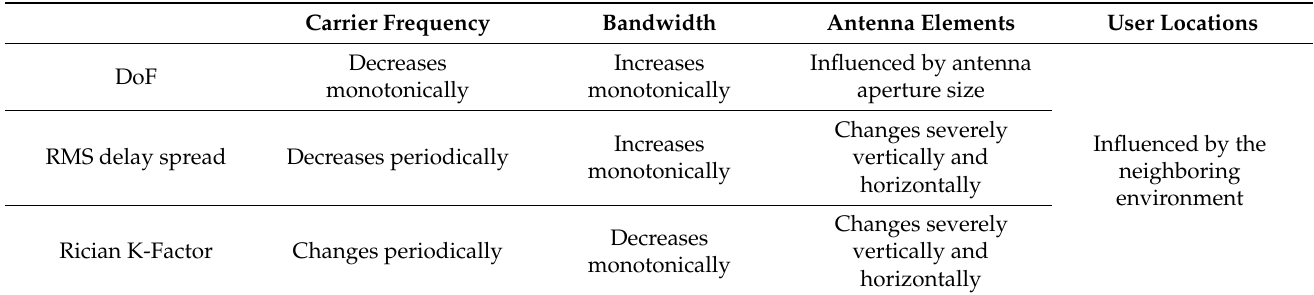
Table 3. Summary of the